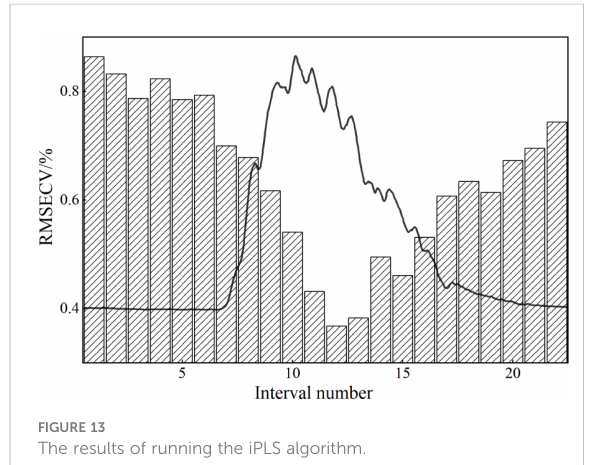
FIGURE 13 The results of running the iPLS